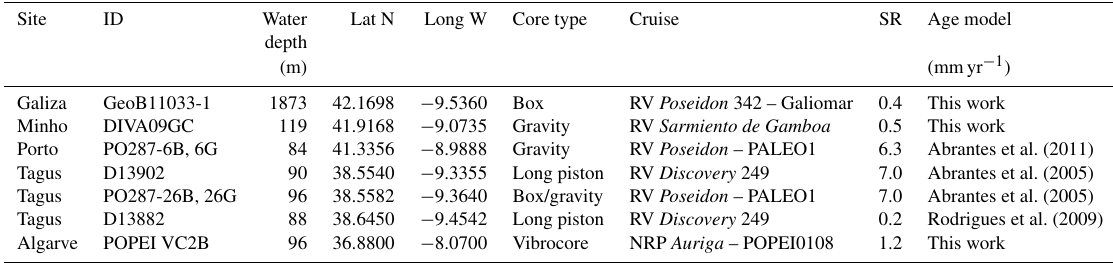
Table 1. ID, water depth, geographic location, core type, sampling cruise, sedimentation rate (SR) and age-model origin of the seven sedimentary sequences used in this